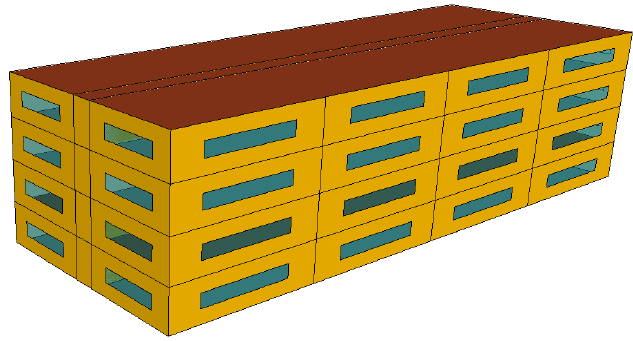
Figure 10. Apartment building.